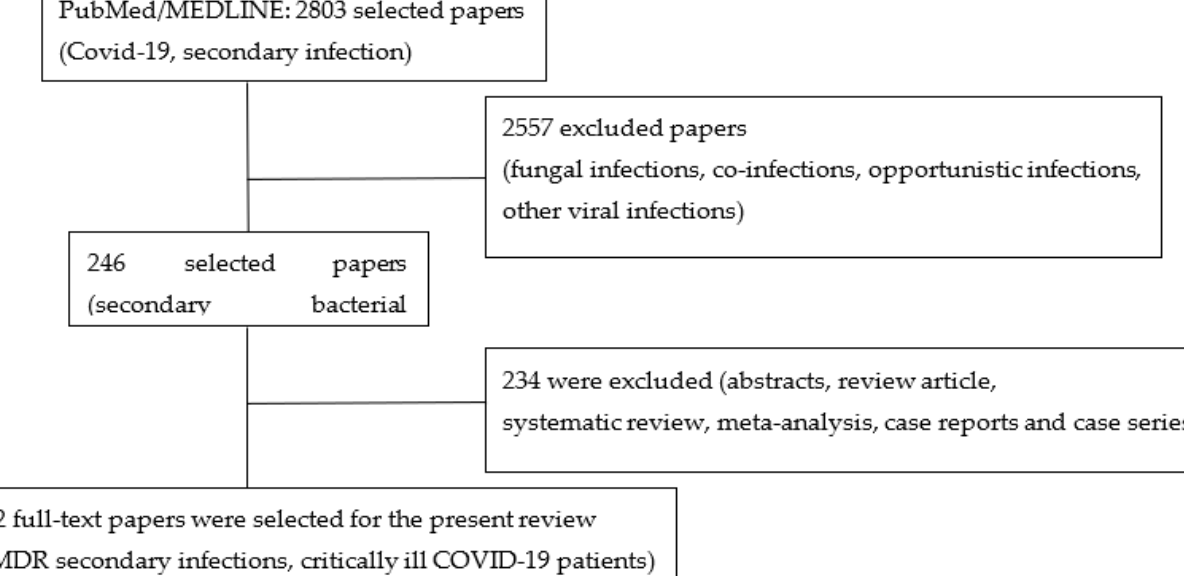
Figure 2. Flow diagram of the literature selection process for the present article.